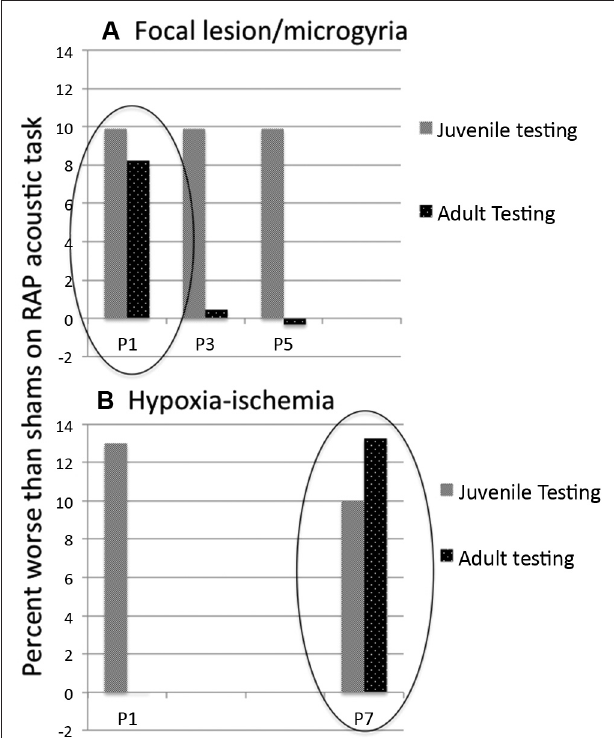
FIGURE 3 | Mean difference in percent attenuation as compared to matched shams on a rapid acoustic processing discrimination task. Behavioral measures were obtained in juvenile (about P30) and adult (about P60) rats (repeated testing, same subjects). (A) Subjects with lesions induced on P1 and P3 showed cortical microgyric malformations in post mortem analysis. Subjects with P5 lesions showed only glial scarring. All subjects showed deficits relative to matched shams in juvenile testing. In adulthood, only P1 lesioned (microgyric) subjects were significantly impaired as compared to shams. Data adapted from Threlkeld et al. (2006). (B) For subjects with HI induced on P1 and P7, both groups again showed deficits in the juvenile period, but only P7 HI remained impaired relative to matched shams in adulthood. Data adapted from McClure et al.